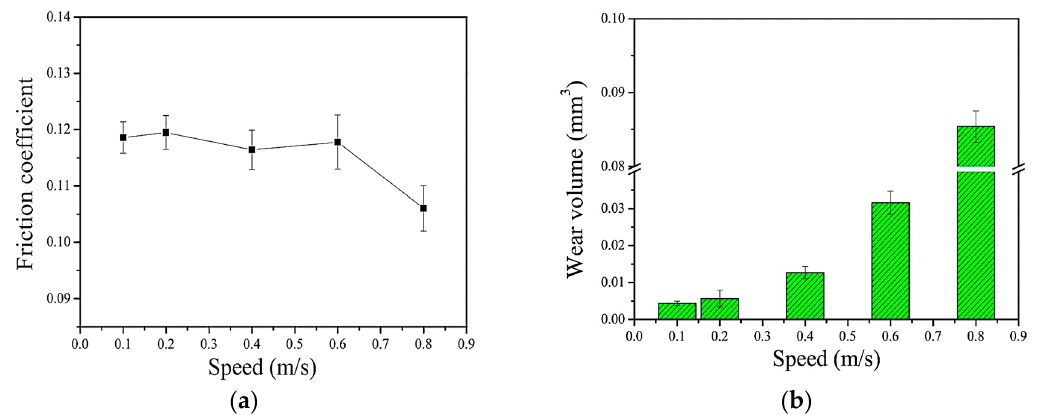
Figure 3. The change of friction coefficient and wear under different speeds: ( a ) Friction coefficient vs. speed; ( b ) wear volume vs. speed.